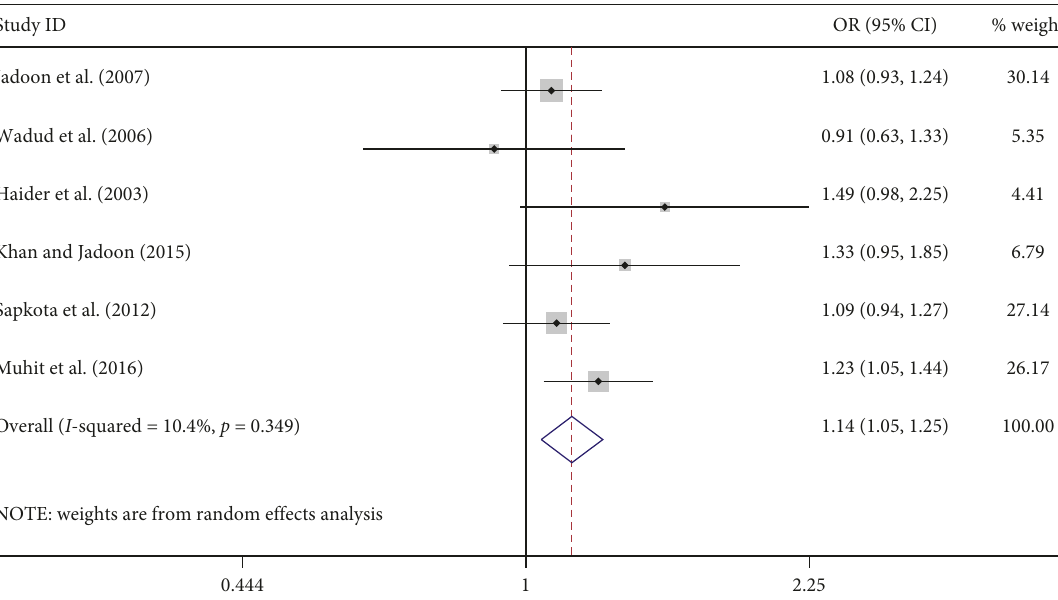
Figure 3: Forest plot showing the meta-analysis of CSC by sex on a person basis at visual < 6/18 level. CSC � cataract surgical coverage; OR � odds ratio; CI � confidence interval.